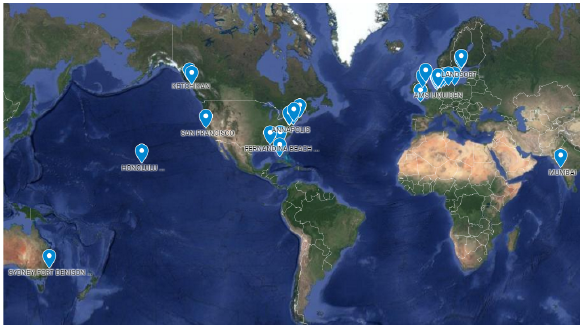
Figure 1: The locations of the tide gauge stations used in this study are indicated with drops (Google map,